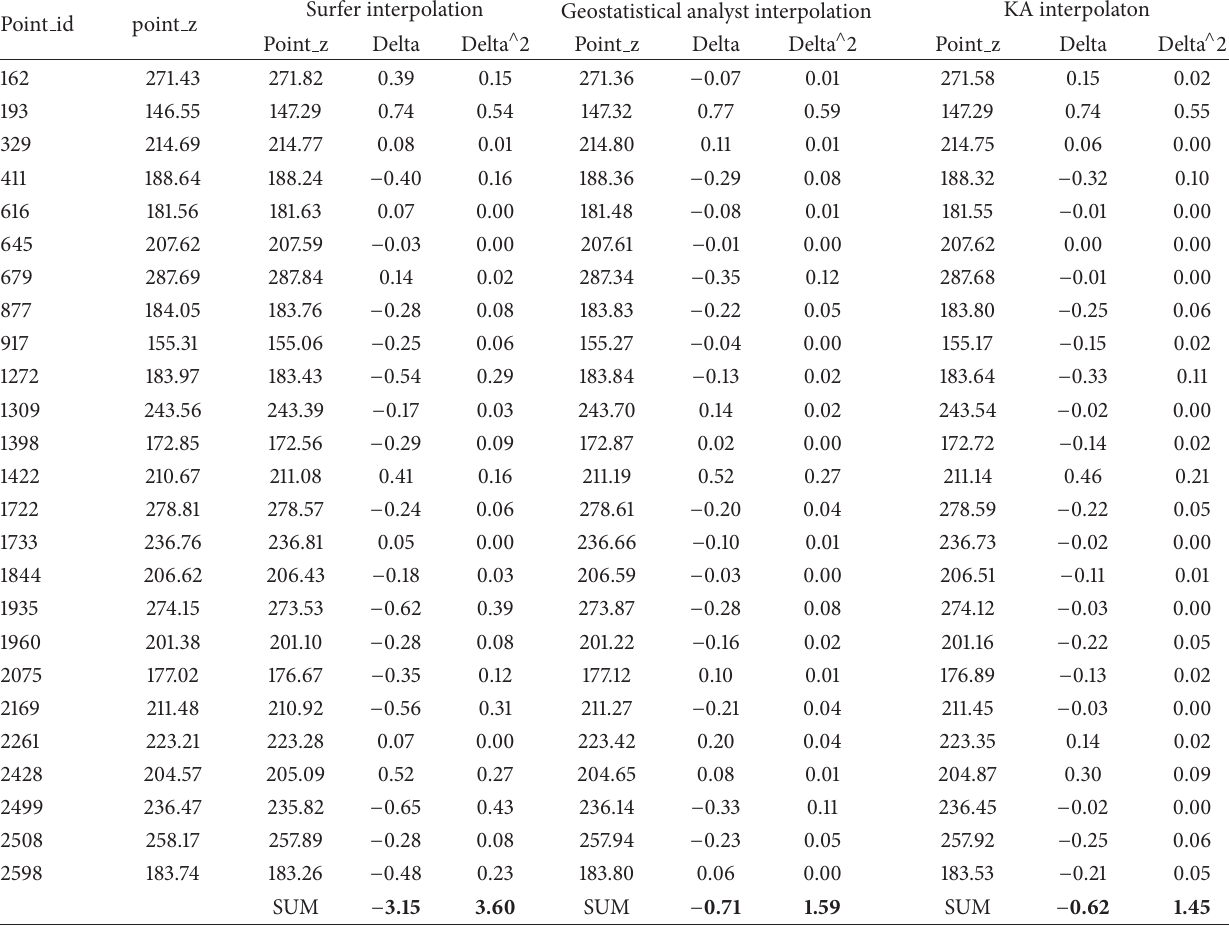
Table 2: Comparison between kriging results and true values.